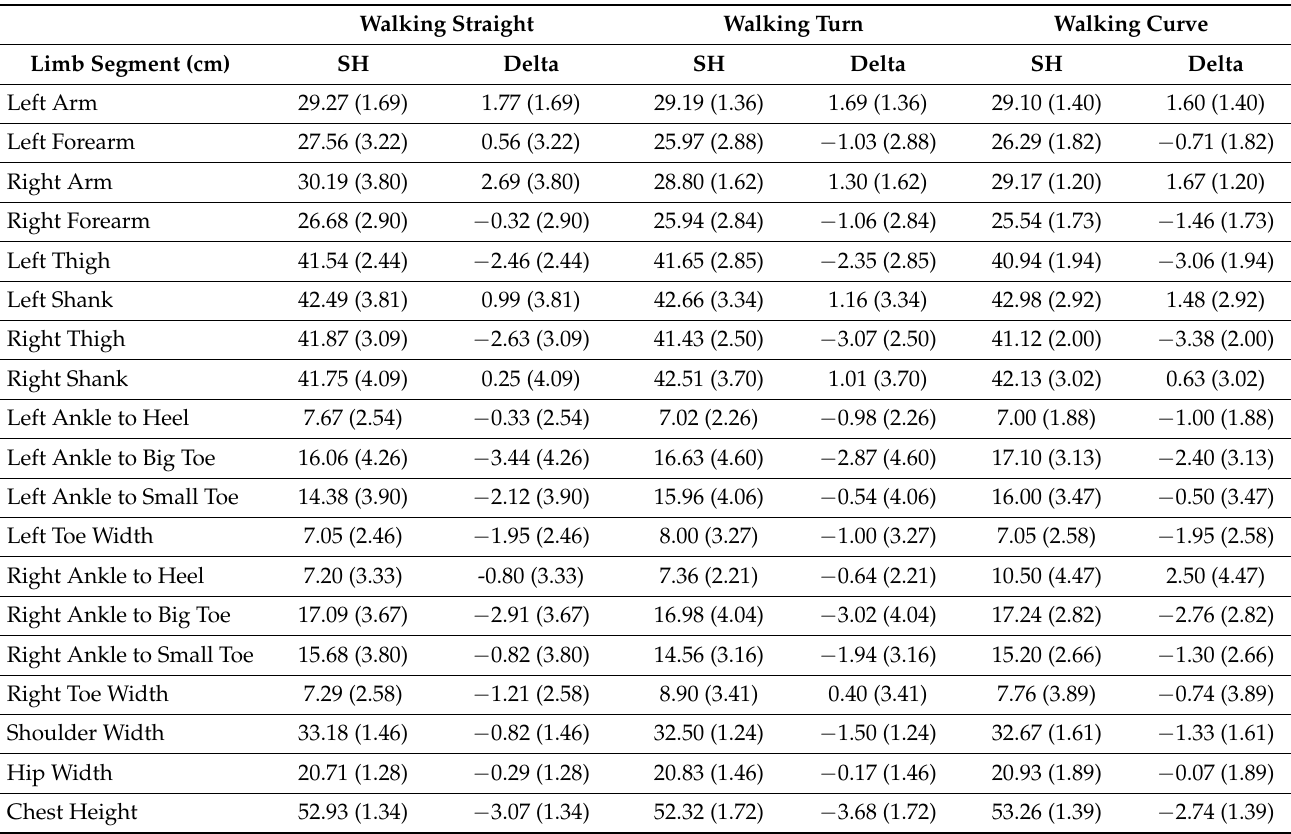
Table A5. Body-segment lengths for participant two: walking-straight, walking-turn, and walker-curve conditions (mean and standard deviation in brackets). Smart Hallway (SH) is calculated using the 3D reconstructed data, and Delta is the difference between the Smart Hallway and ground-truth segment length.